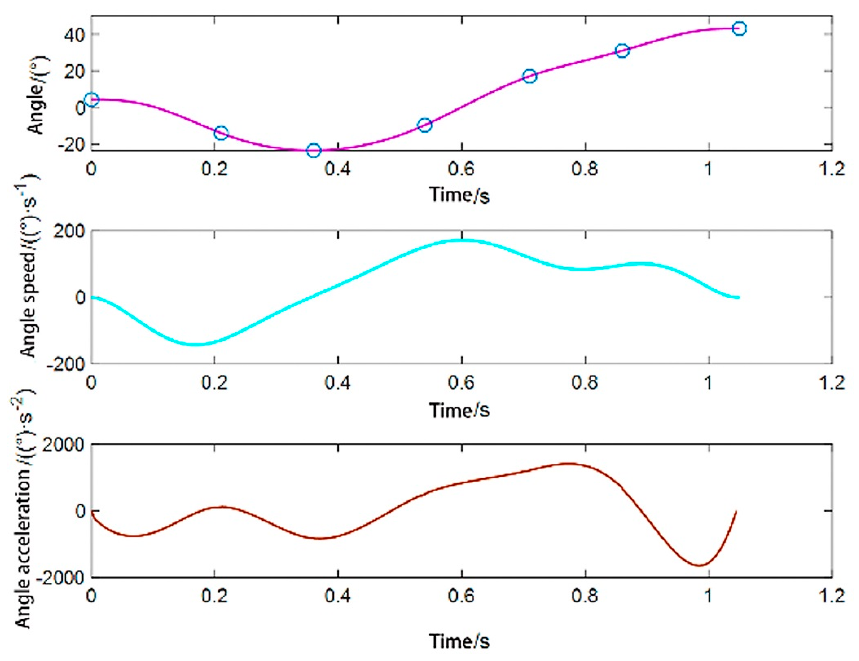
Figure 10. Plot of the angle, angle velocity, and angle acceleration of joint 2.